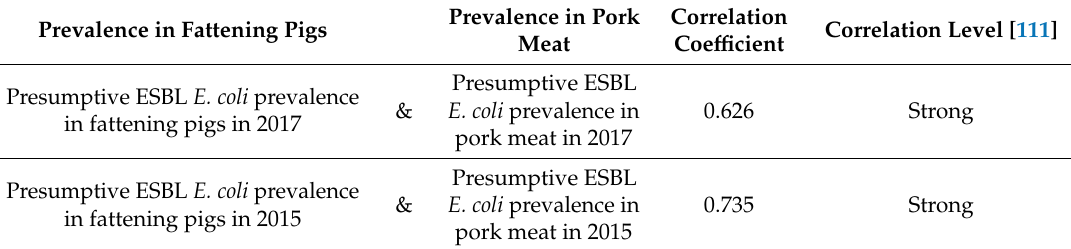
Table 5. Correlation between prevalence of presumptive ESBL E. coli in fattening pigs and pork